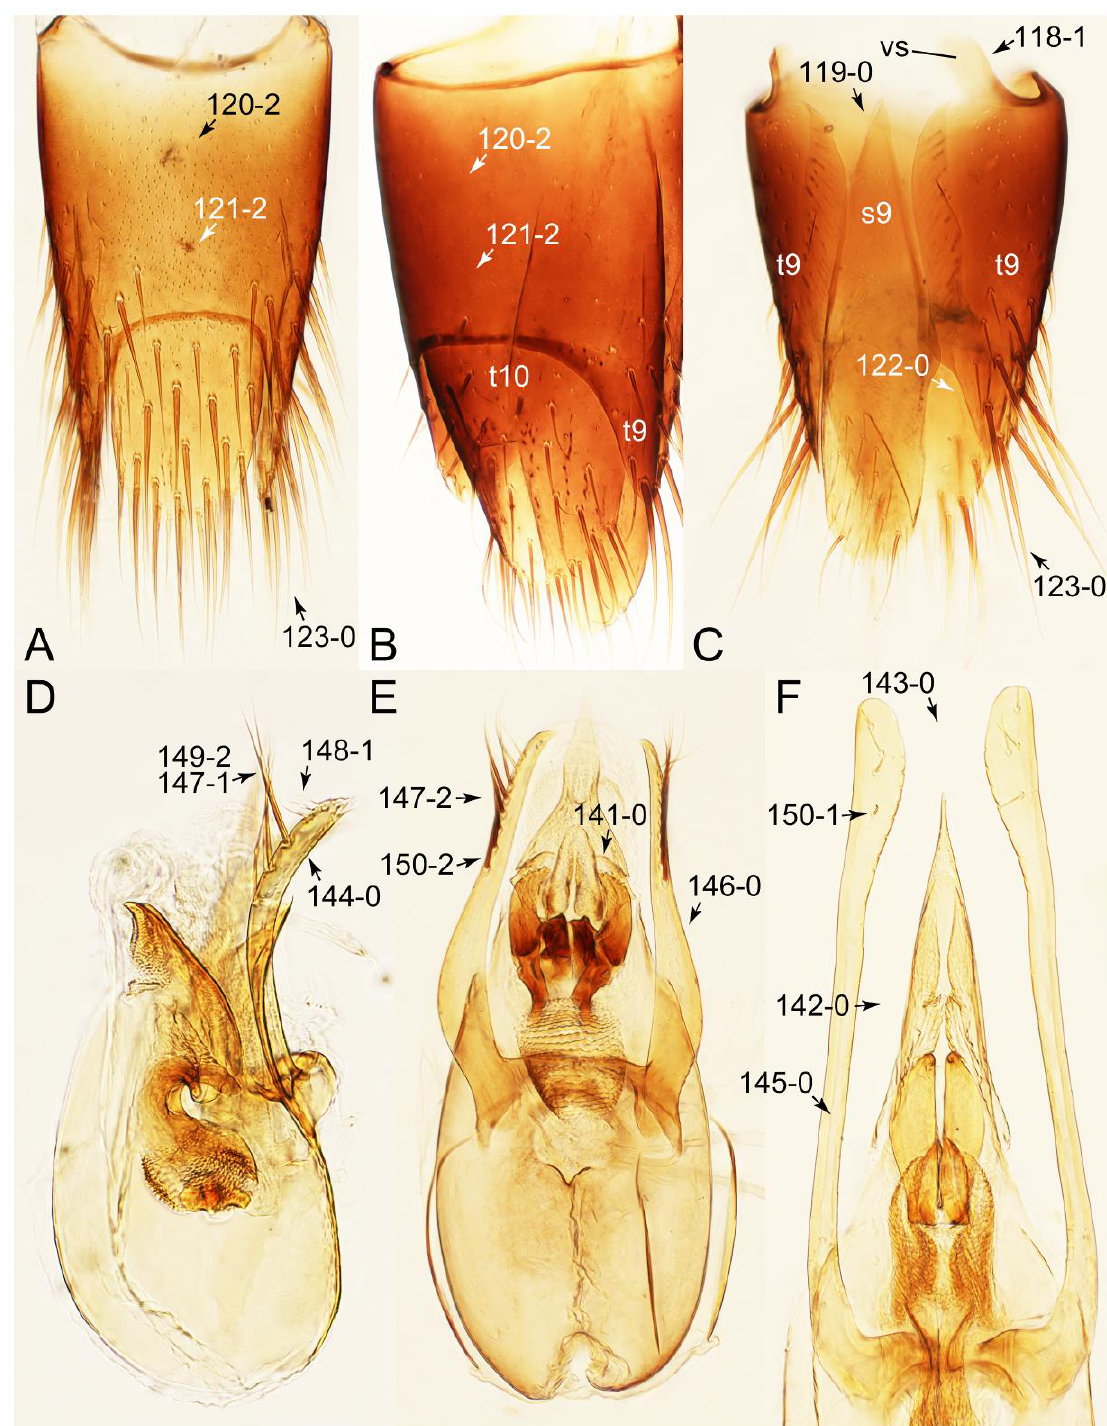
Figure 72. Photographs of body parts of Mycetoporinae, male genital segments and aedeagus, enlarged. ( A ) tergites IX–X of Bryoporus cf. orientalis , dorsal view. ( B ) tergites IX–X of Bobitobus lunulatus , dorsolateral view. ( C ) tergites IX and sternite IX of Ischnosoma splendidum , ventral view. ( D ) aedeagus of Bryophacis smetanai , lateral view. ( E ) aedeagus of Bobitobus lunulatus , ventral view. ( F ) aedeagus of Parabolitobius formosus , ventral view. Abbreviations: s9, sternite IX; t9–10, tergite IX–X; vs, ventral strut. Characters and character states (format X-X) are indicated on each